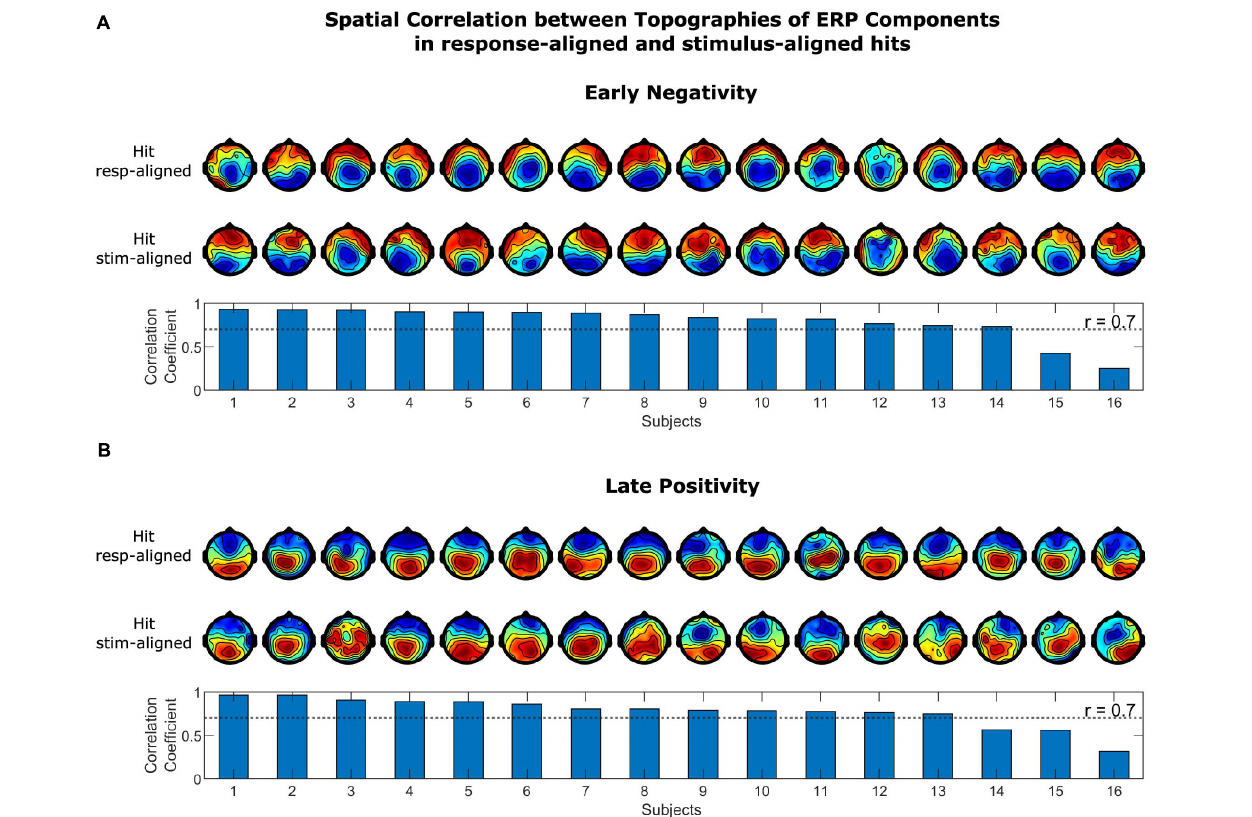
FIGURE 5 | Spatial correlation between topographies of ERP Components in stimulus-aligned and response-aligned hits for (A) the early negativity and (B) the late positivity. Topographies in the upper row correspond to response-aligned hits and in the lower row to stimulus-aligned hits. Scalp topographies of the components were highly correlated in stimulus-aligned and response-aligned hits across most of the